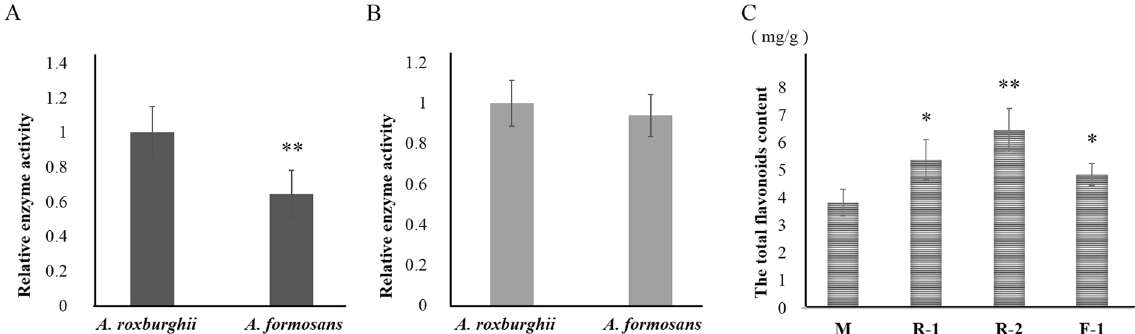
Figure 3. Relative enzyme activity of E . coli striansand total flavonoids content of rice lines heterologously- expressed CHS protein of A. formosanus and A. roxburghii . The asterisk ( * ) and the double asterisk ( ** ) stand for significance (P ≤ 0.05) and great significance (P ≤ 0.01), respectively. ( A ) in vitro enzyme activity. ( B ) in vivo